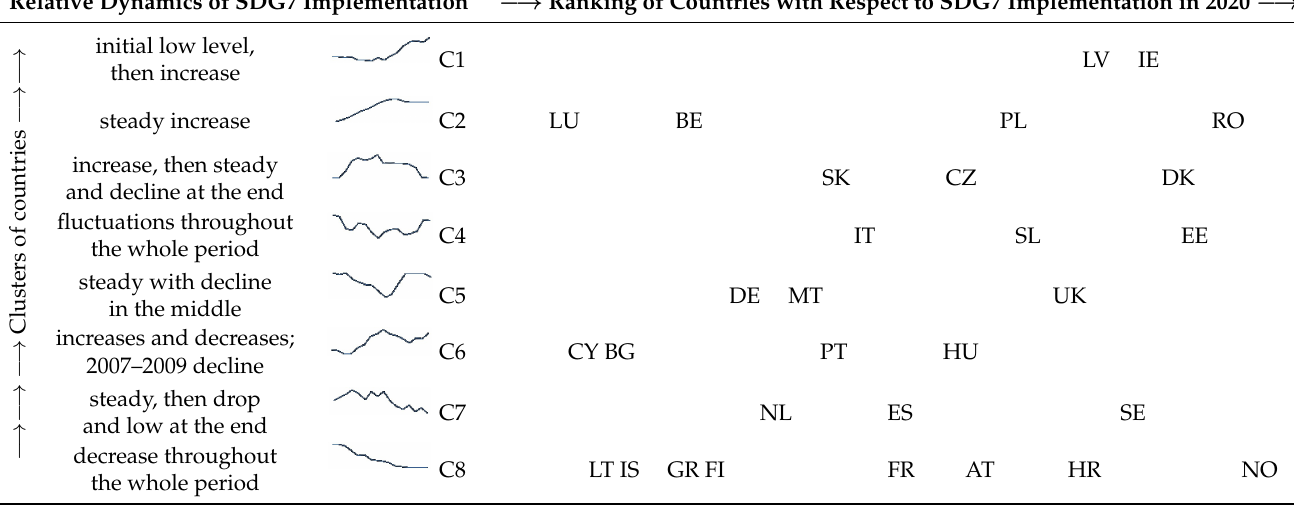
Table 2. Relation between relative dynamics of SDG7 implementation and ranking of countries in 2020. Source: own elaboration .